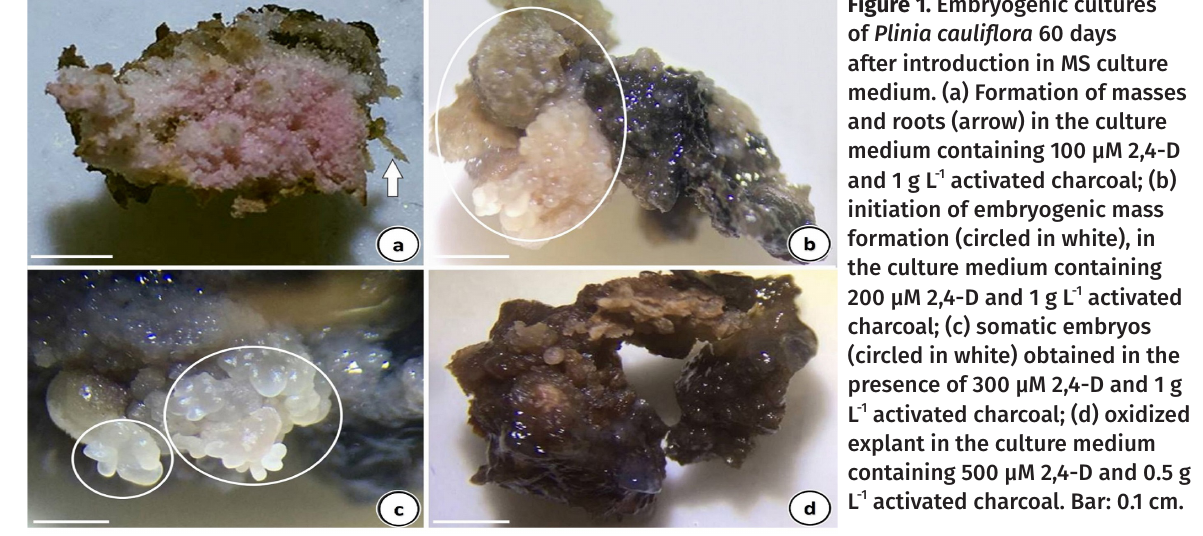
Figure 1. Embryogenic cultures of Plinia cauliflora 60